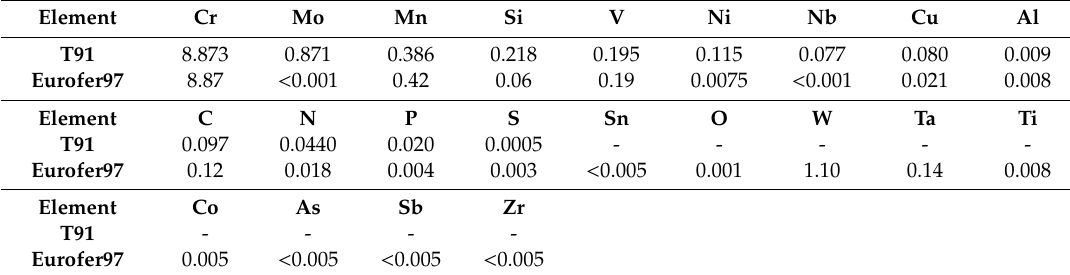
Table 1. Chemical composition of the T91 and Eurofer97 materials (in wt.%; Fe